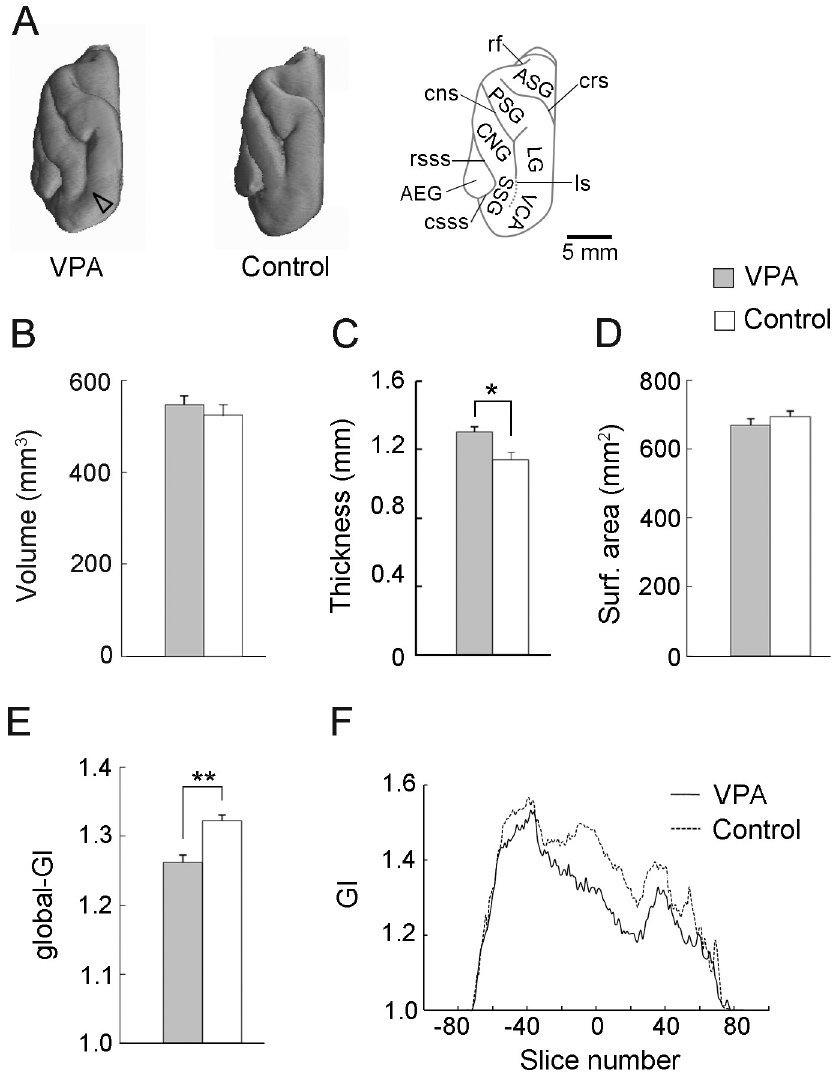
Fig 1. Developmental VPA treatment alters some aspects of cortical development at PD 20. (A) 3D-rendered images of the left cerebral hemisphere, dorsal view, for VPA-treated (left) and control (center) ferrets. An illustration of the dorsal surface of the left hemisphere indicating primary gyri and sulci (right). (B) Cortical volume. (C) Mean cortical thickness throughout the cerebral hemisphere. The values were computed from reconstructed 3D cortices generated from semi-automatically segmented images based on 3D MRIs. (D) Cortical surface area. (E) Global- gyrification index (global-GI). (F) Rostrocaudal distribution of the GI throughout the cerebral hemisphere. Compared to controls, lower GI values were observed in VPA-treated ferrets in the intermediate region around the anterior commissure on the rostrocaudal axis. Data are shown as mean ± SEM. Significance is indicated for Student’s t -tests at � P < 0.01, �� P < 0.001, number of cerebral hemispheres = 8. AEG, anterior ectosylvian gyrus; ASG, anterior sigmoid gyrus; CNG, coronal gyrus; cns, coronal sulcus; crs, cruciate sulcus; csss, caudal suprasylvian; LG, lateral gyrus; ls lateral sulcus; PSG, posterior sigmoid gyrus; rsss, rostral suprasylvian sulcus; SSG, suprasylvian gyrus; VCA, visual cortical area.